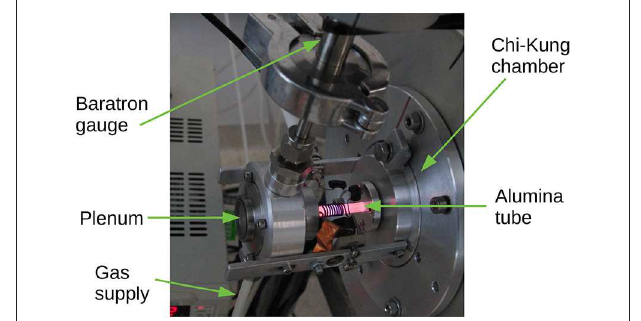
FIGURE 2 | A simplified sketch of the inductive PR, shown here connected to the Chi-Kung expansion chamber at lower pressure (as seen in Figure 1 ). The Pyrex glass inside the chamber is part of a different experiment also run on Chi-Kung and bears no significance in the experiments described in this paper.